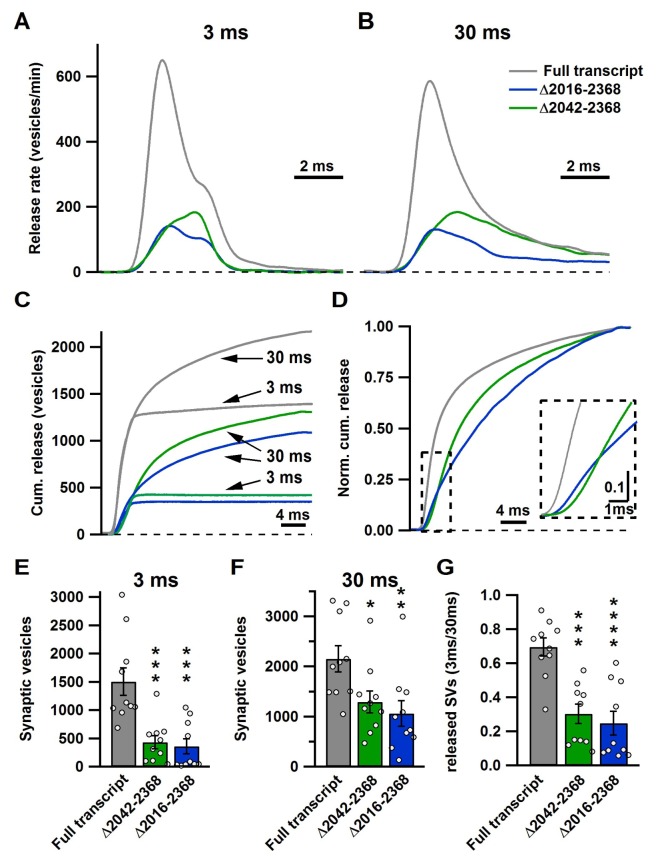
The novel C-terminal region between amino acids 2042 and 2061 regulates size of the fast and total releasable pool and synaptic vesicle release kinetics.(A–B) Average release rate trace after 3 ms (A) or 30 ms stimulation (B) from calyces expressing either Cre + full transcript rescue (grey), Δ2042–2368 (green) or Δ2016–2368 (blue); n = 10 for each group; (C) Averaged cumulative release after 3 ms and 30 ms stimulation. (D) Normalized cumulative release of the total releasable pool triggered by 30 ms stimulation. Inset presents a magnified view of the area encircled by the dashed box. (E–G) Quantification of SV numbers released by 3 ms (E) and 30 ms (F) as well as the ratio of SVs released by 3 ms and 30 ms stimulation (G). All data are depicted as mean ± SEM.